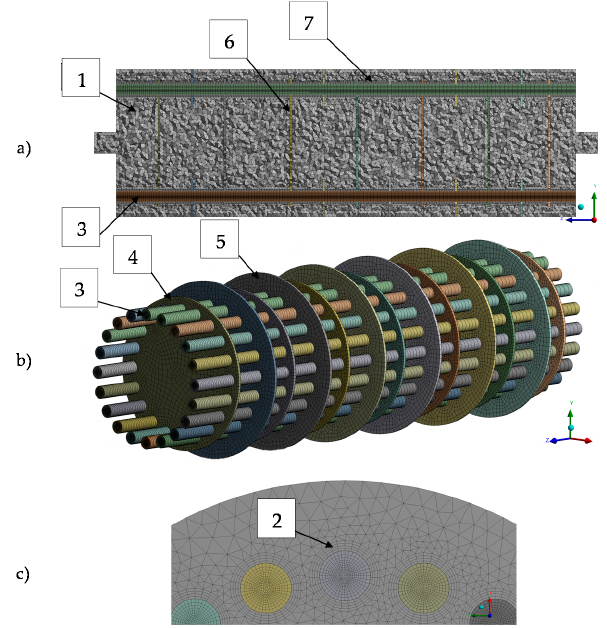
Figure 3. Model mesh.( a ) All domains; ( b ) Tubes and baffles sub-domains; ( c ) Tubes inlet detail. 1) Tetrahedral mesh in coolant domain. 2) Inflation layers detail at tubes wall. 3) Hexahedral mesh in tube domains. 4) Hexahedral mesh at Disk type baffle. 5) Hexahedral mesh at Doughnut type baffle. 6) and 7) Non-conformal interface zones, between coolant and tubes/baffles